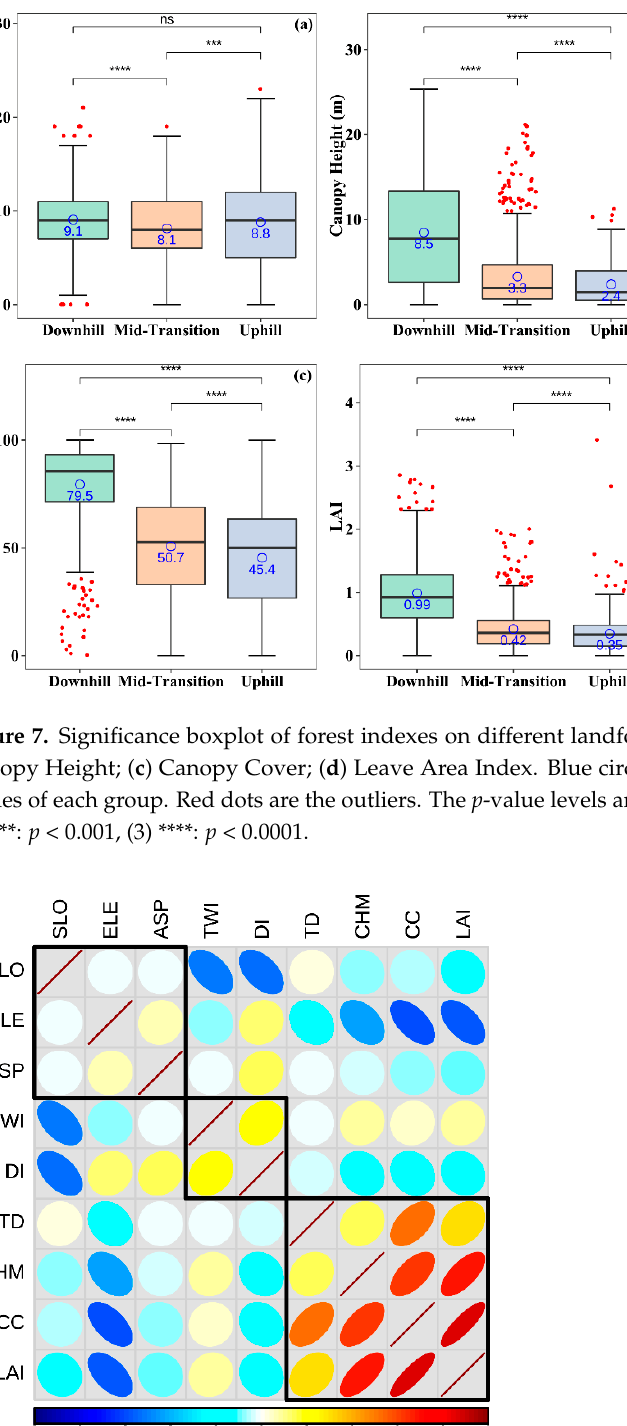
Figure 6. Significance boxplot of topographical indexes on different landform units. (a) Elevation; (b) Aspect; ( c ) Slope; (d) Topographic Wetness Index; (e) Direct Insolation. Blue circles and numbers are the mean values of each group. Red dots are the outliers. The p -value levels are symbolized as (1) ns: p > 0.05, (2) *: p < 0.05, (3) ***: p < 0.001, (4) ****: p < 0.0001.